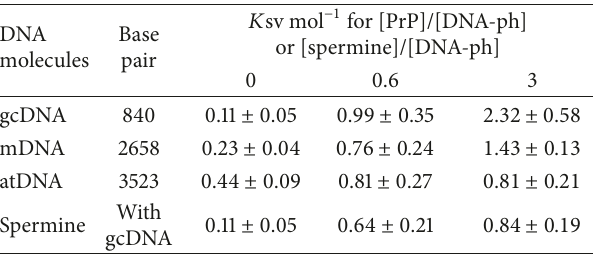
Table 1: Stern-Volmer constant 𝐾 sv for the accessibility of YOYO bound to different DNAs in the presence of 𝛼 -PrP or spermine in Hepes buffer, pH 7.4 containing 100 mM